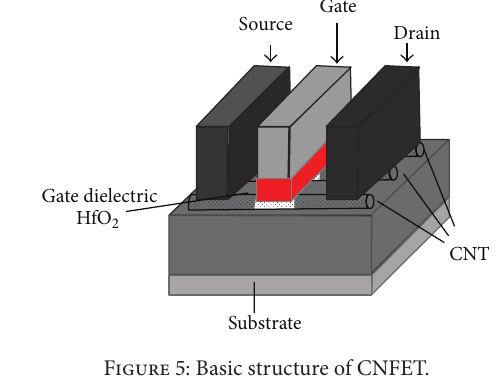
Figure 5: Basic structure of CNFET.